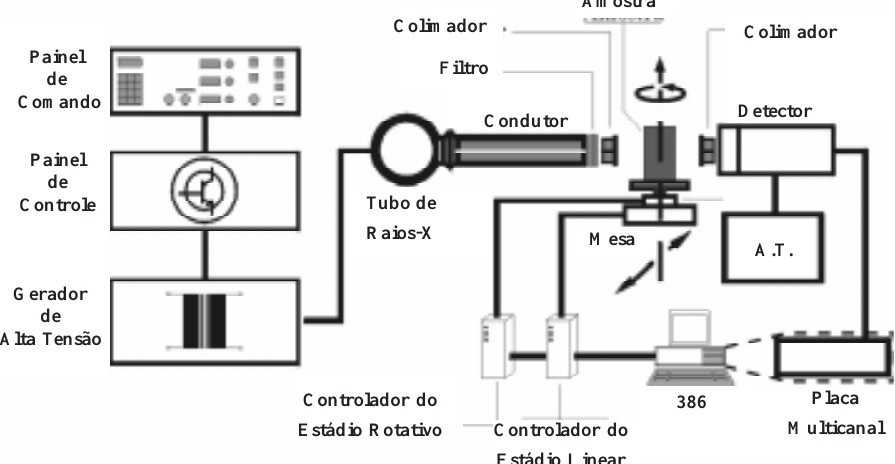
Figura 1. Diagrama de blocos do tomógrafo com resolução micrométrica.